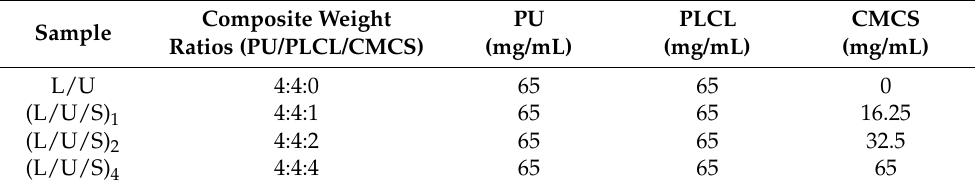
PU-Polyurethane; PLCL-Poly(L-Lactide-co-caprolactone); CMCS-Carboxymethyl